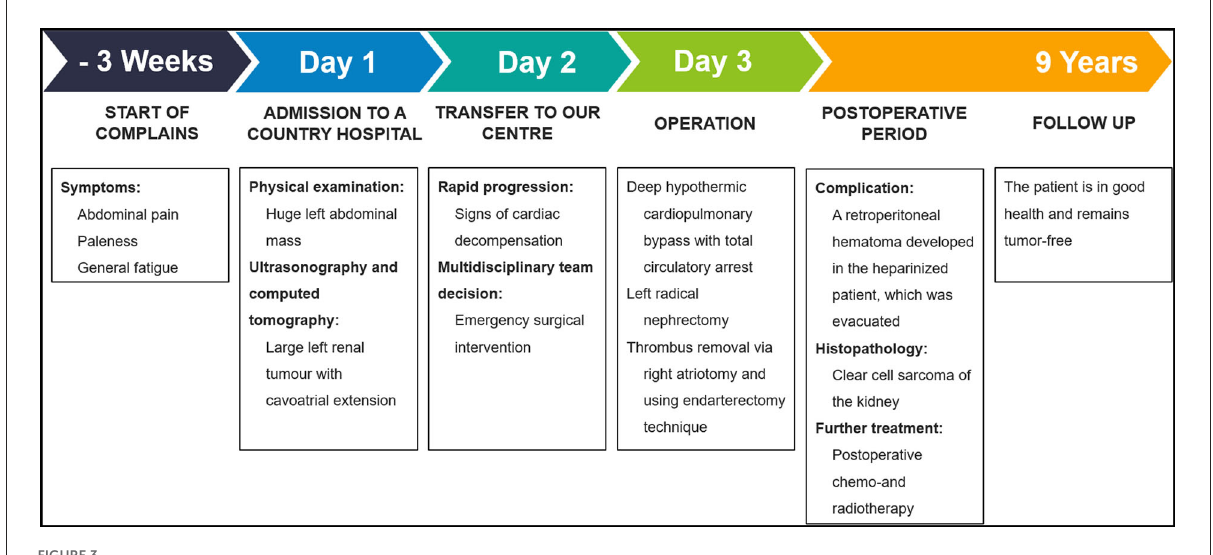
FIGURE3 Timeline summarizing the major events of the